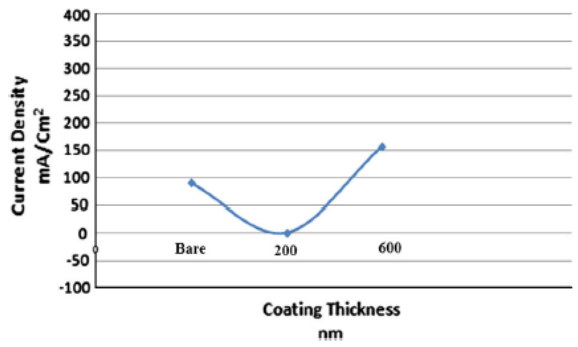
Figure 10. Current density vs. coating thickness graph SS-316L [85].